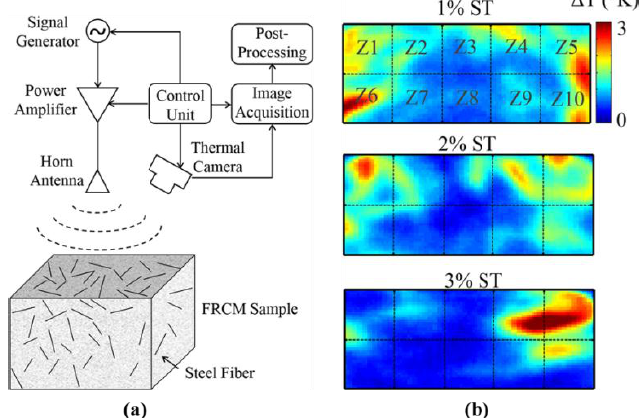
Figure 21. MWT measurement setup ( a ) and specimen surface temperature variation with different steel fiber contents ( b ) [73]. Reprinted/reproduced with permission from Springer.